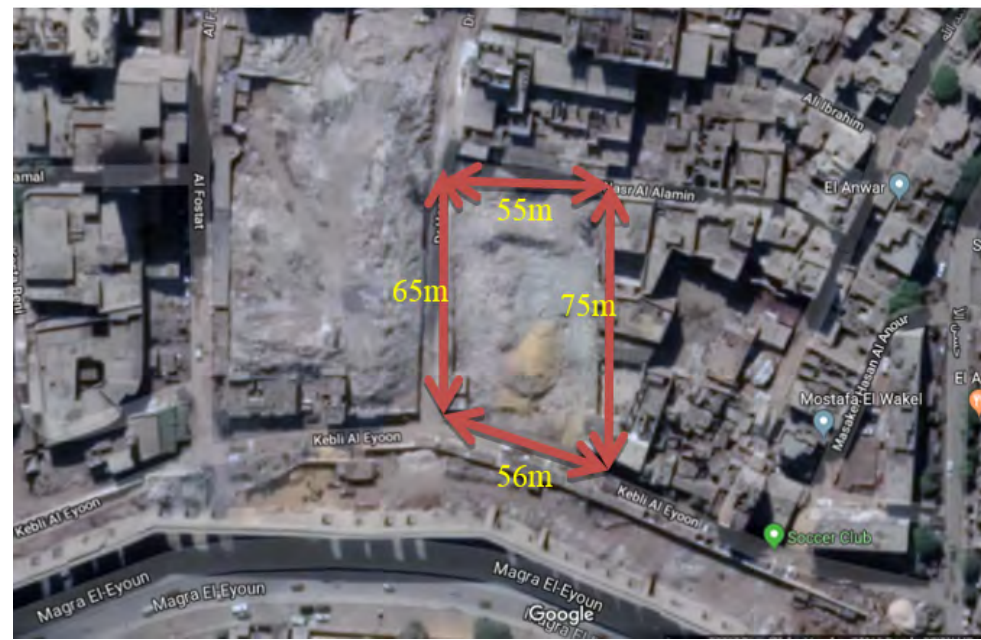
Figure 2. A satellite image for the site with dimensions (Google